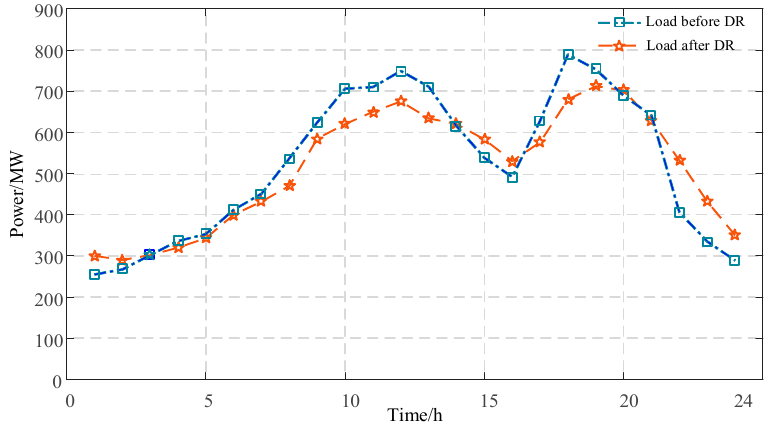
Figure 7. System load curve before and after demand response.